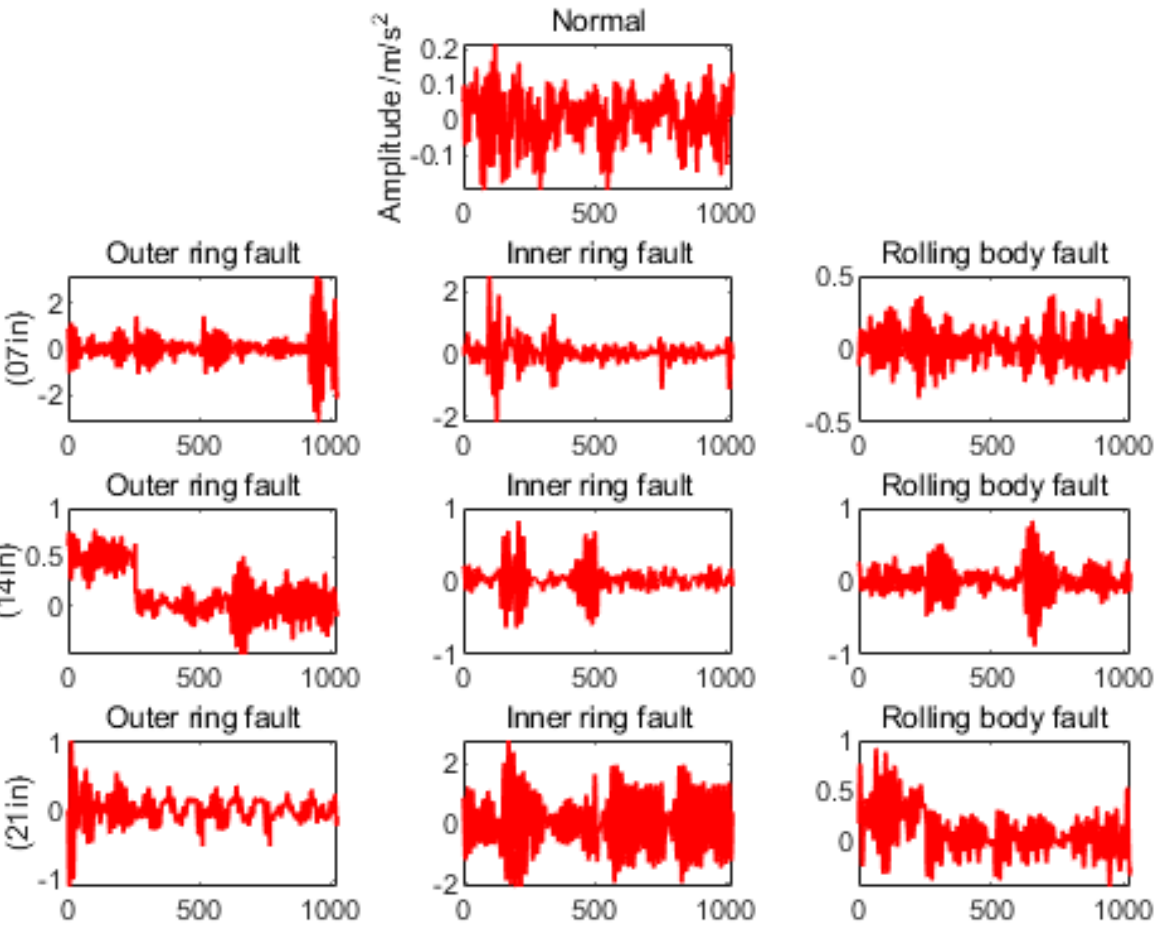
Figure 9. Visual analysis of rolling bearing data (occurring on outer ring, inner ring, and rolling body with single point diameter damage of 0.007 mm (07 in), 0.014 mm (14 in), and 0.021 mm (21 in), respectively).